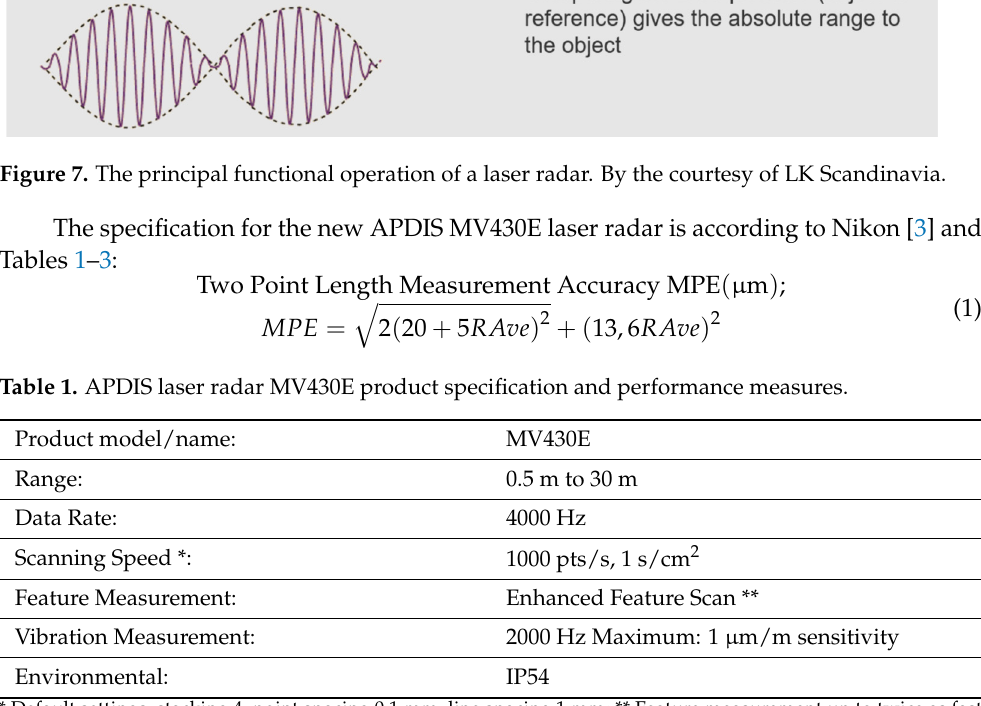
Figure 7. The principal functional operation of a laser radar. By the courtesy of LK Scandinavia.